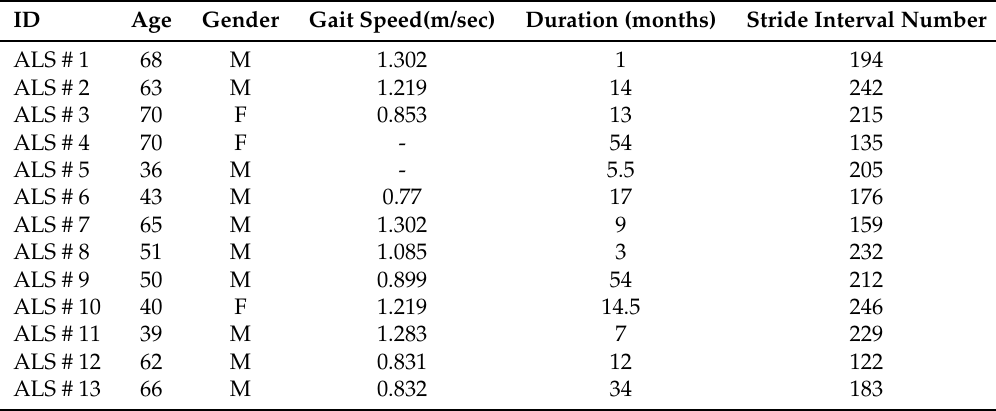
Table 2. The subjects’ clinical information of the amyotrophic lateral sclerosis (ALS)